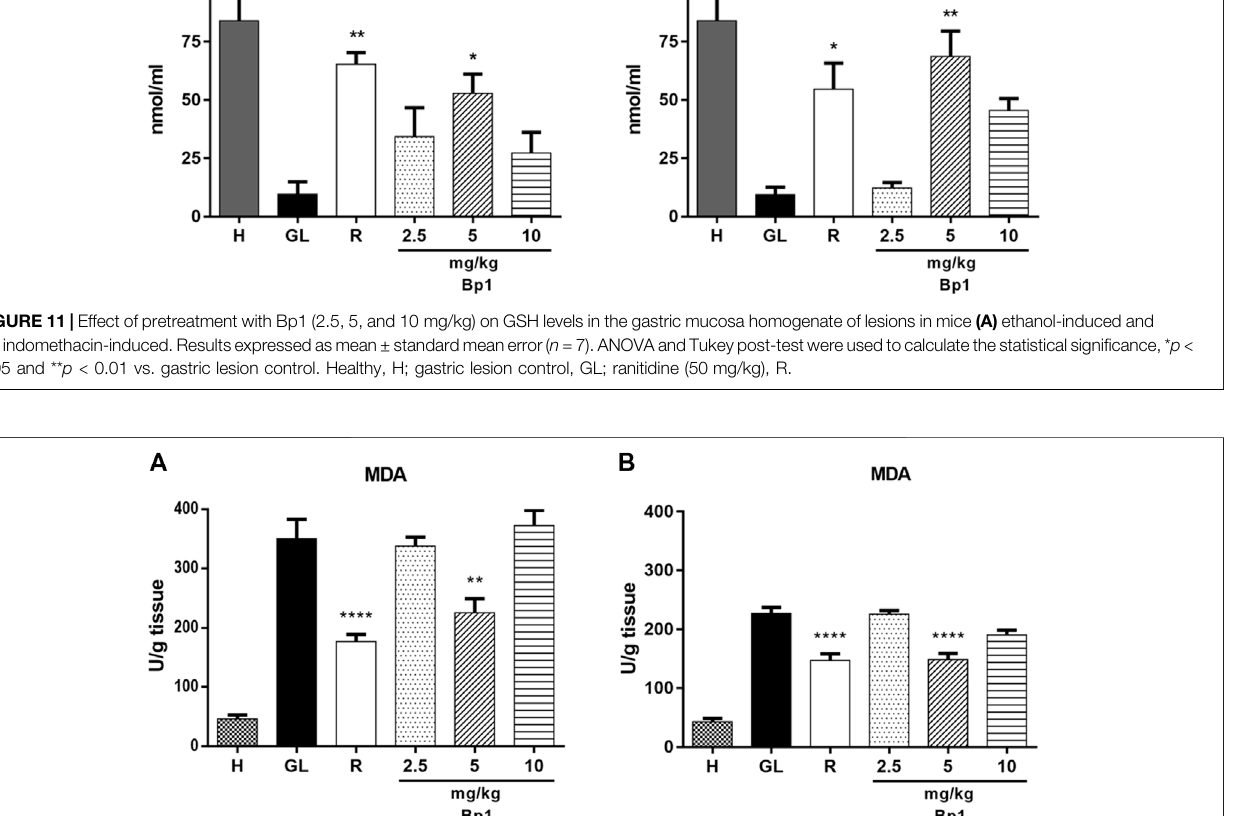
COX-2 and NF- κ B (p65) in the gastric tissue of the ulcerated control group, observed as strong brown (circle), while treatment with B. pinnatum leaf extract at doses of